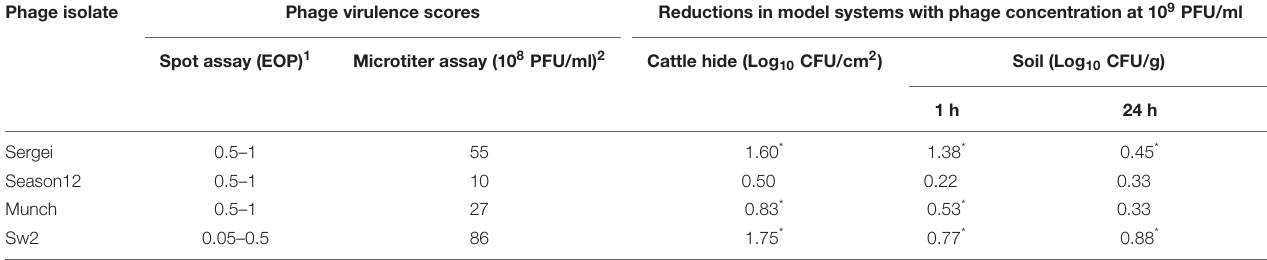
TABLE 3 | Comparison of two methods for measuring phage virulence and the observed phage efficacy in reducing S. Anatum loads in two model systems. Phage